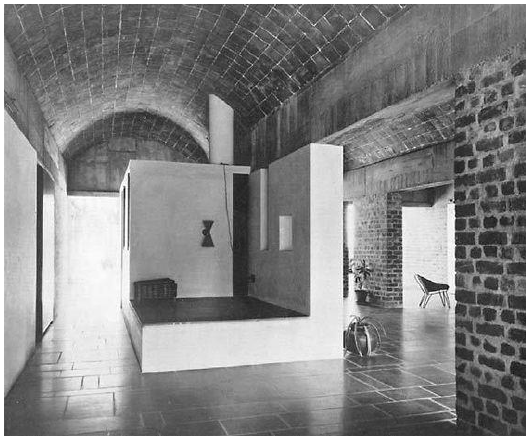
Figure 11. Villa Sarabahi – interior.